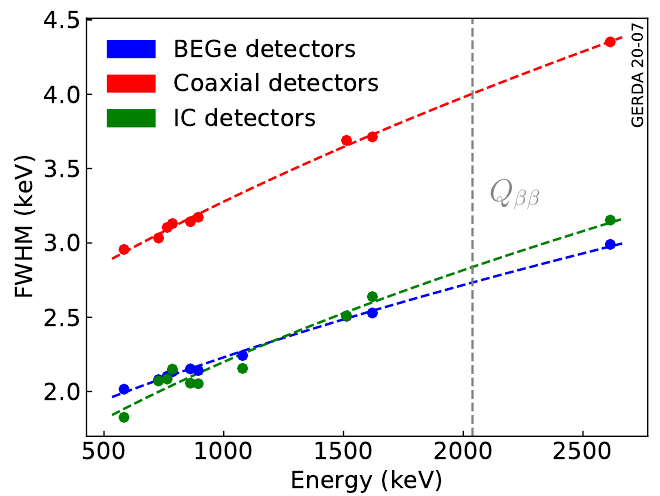
Figure 19. Effective resolution curves for BEGe (blue), coaxial (red) and IC (green) datasets [47].